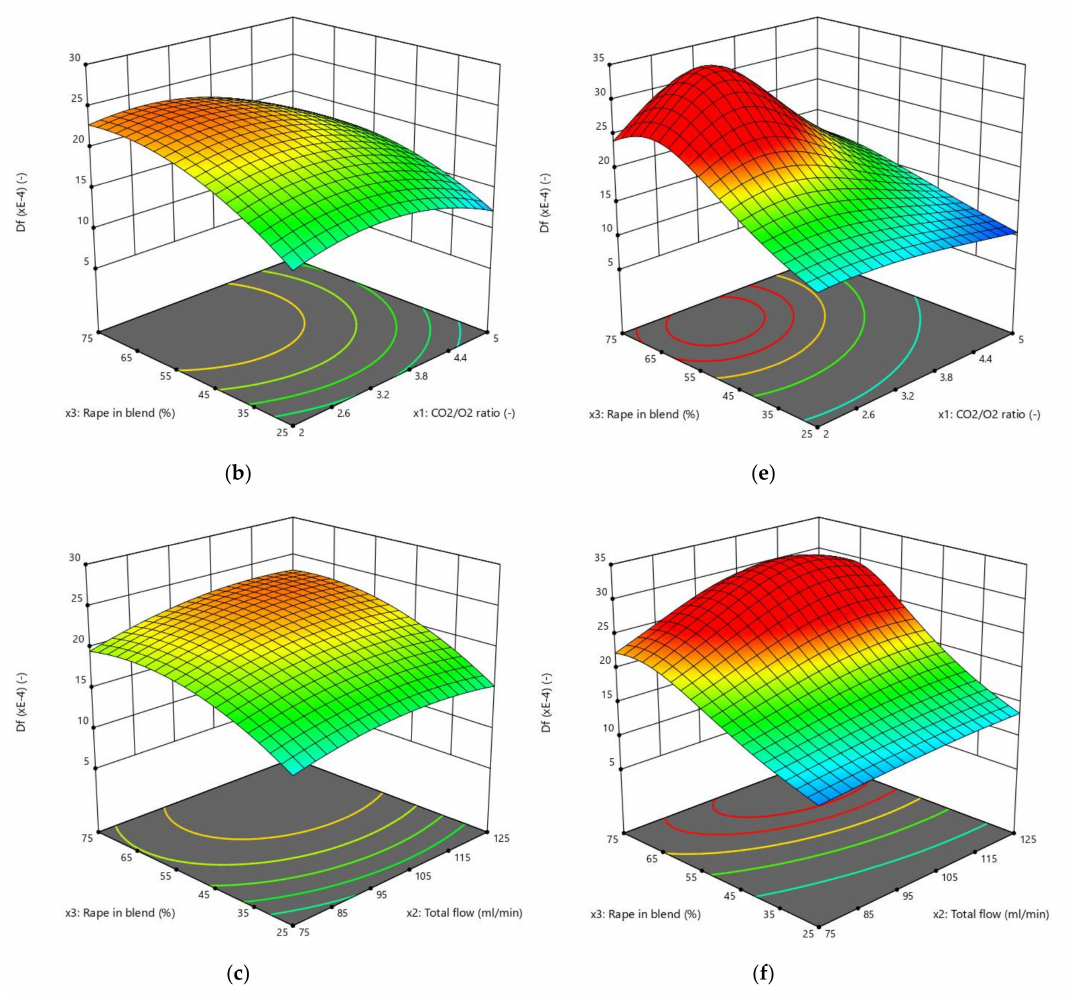
Figure 7. D f response surfaces: ( a – c ) Central composite design; and ( d – f ) Central composite design with power